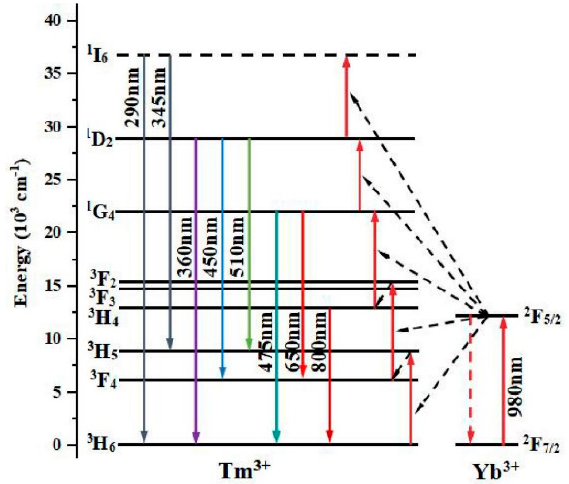
Figure 1. Schematic diagram of energy level transition of Yb 3+ and Tm 3+